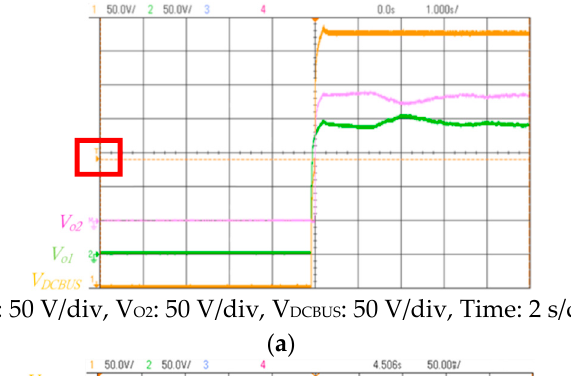
Figure 18. The photograph of the proposed 6 kW LLC converters.